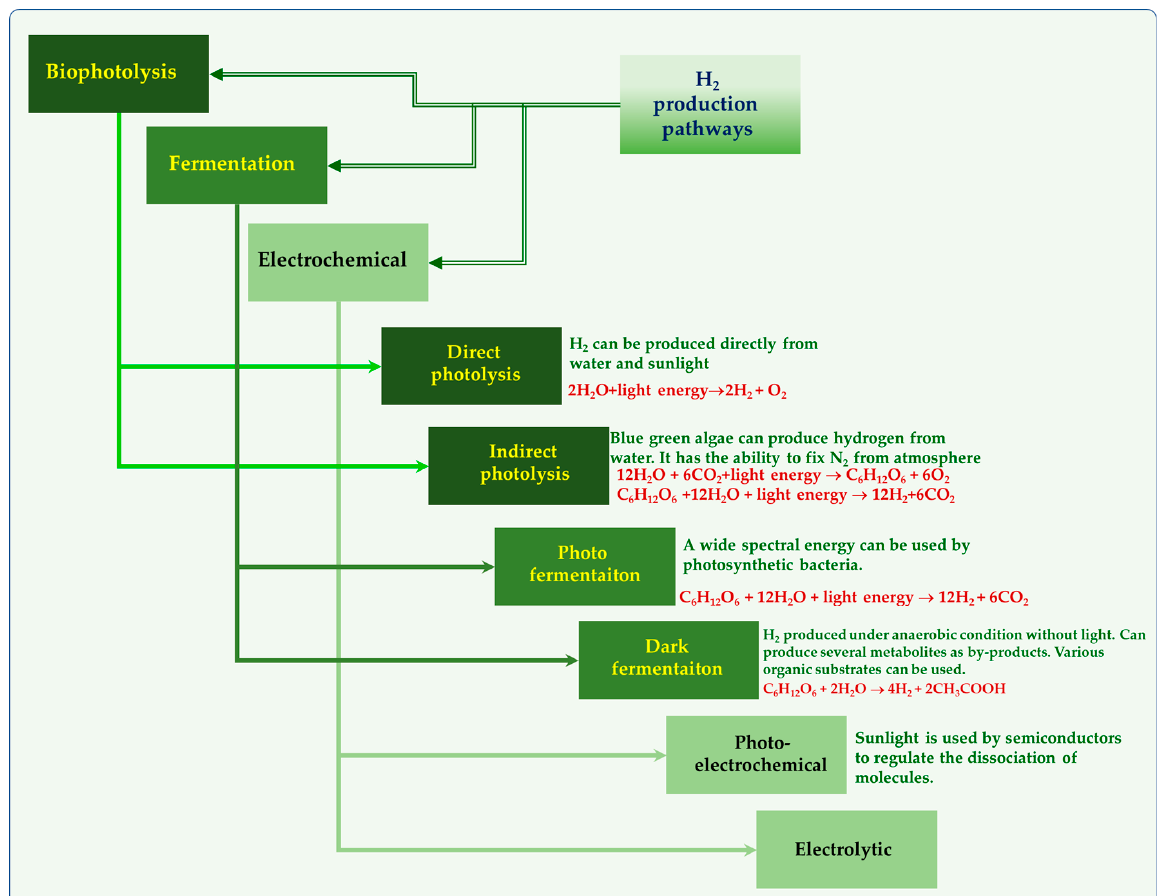
Figure 1. Hydrogen production through various routes.